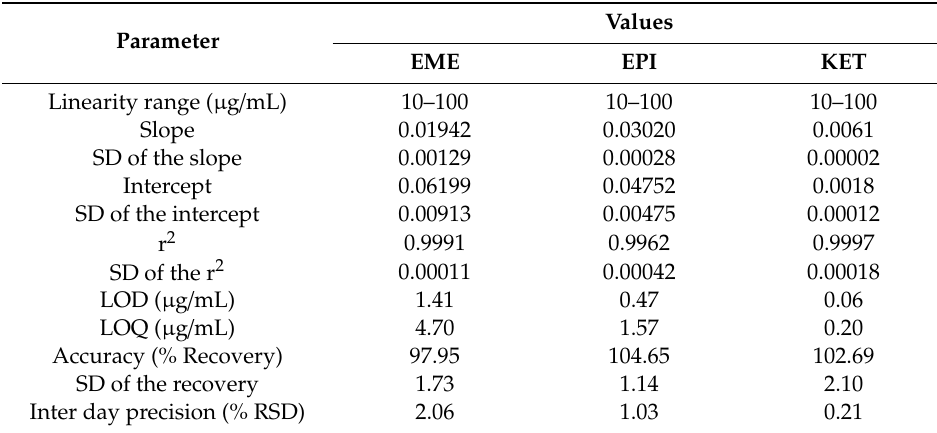
Table 1. Validation of HPLC methods for the determination of emedastine (EME), epinastine (EPI), and ketotifen (KET) ( n = 5).